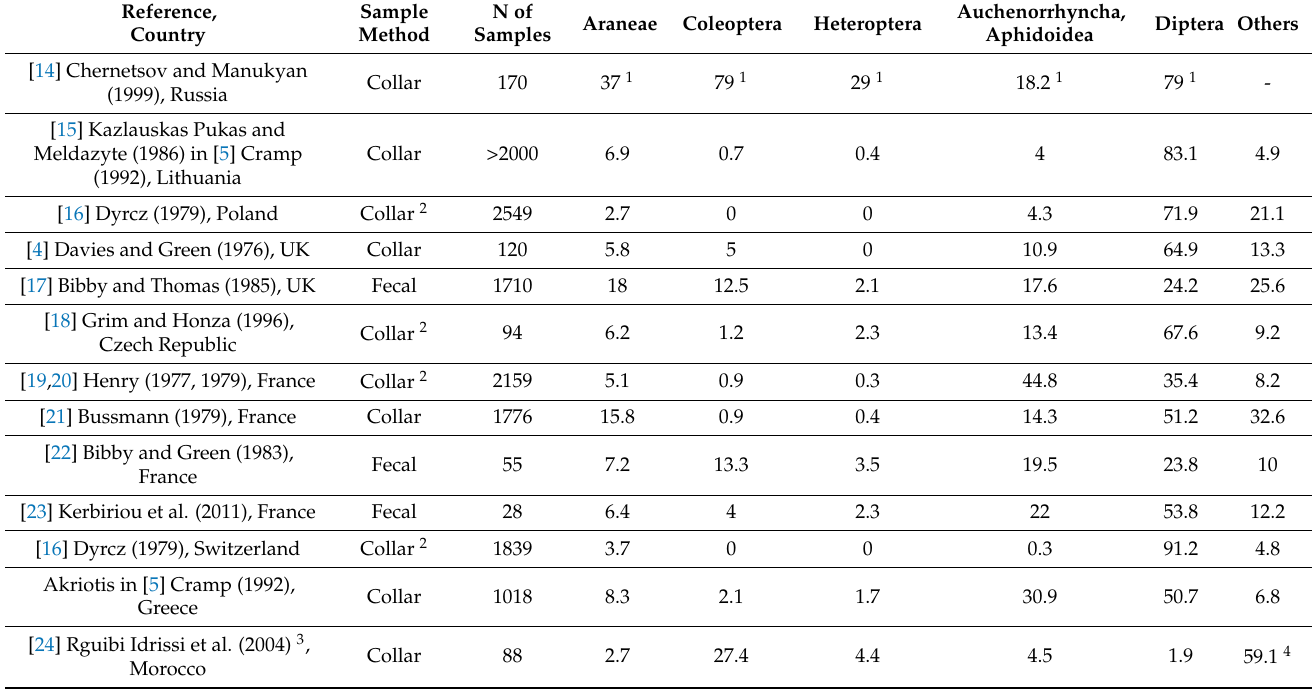
Table 1. Percentage of prey items obtained by different authors in western Palearctic countries with the method of collar-samples or fecal